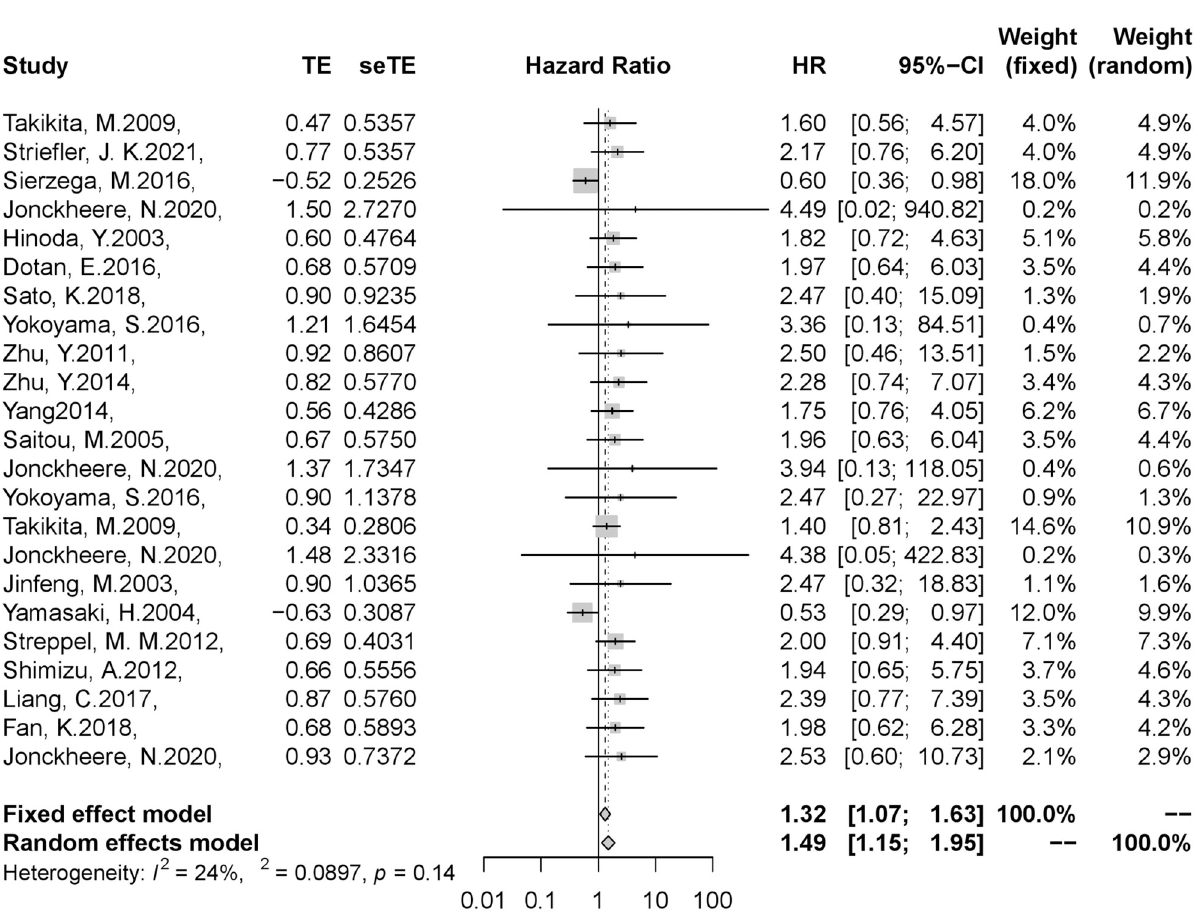
Fig 2. Results of the meta-analysis on pooled HR values. (A) Meta-analysis was performed by overall expression level of mucin. (B)Gray square represented HR of the study and horizontal lines represent 95%CI. Gray diamond represented the pooled HR. (C)We chose fixed effect model because heterogeneity was not significant in this meta-analysis (I 2 = 24%, P = 0.14). Pooled HR = 1.32,95%CI 1.07–1.63.